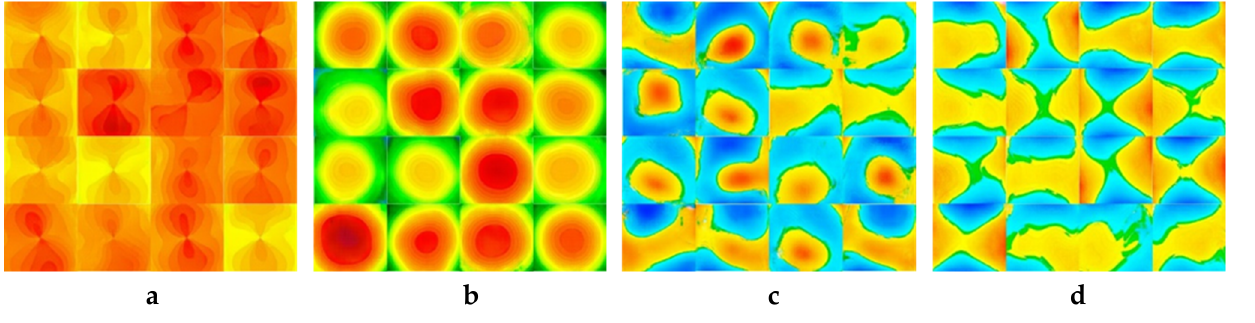
Figure 3. Samples of the generated images for different corneal conditions using the Conditional Generative Adversarial Network (CGAN) model ( a ) normal and abnormal corneal sagittal maps ( b ) normal and abnormal corneal thickness maps ( c ) normal and abnormal corneal elevation front maps ( d ) normal and abnormal corneal elevation back